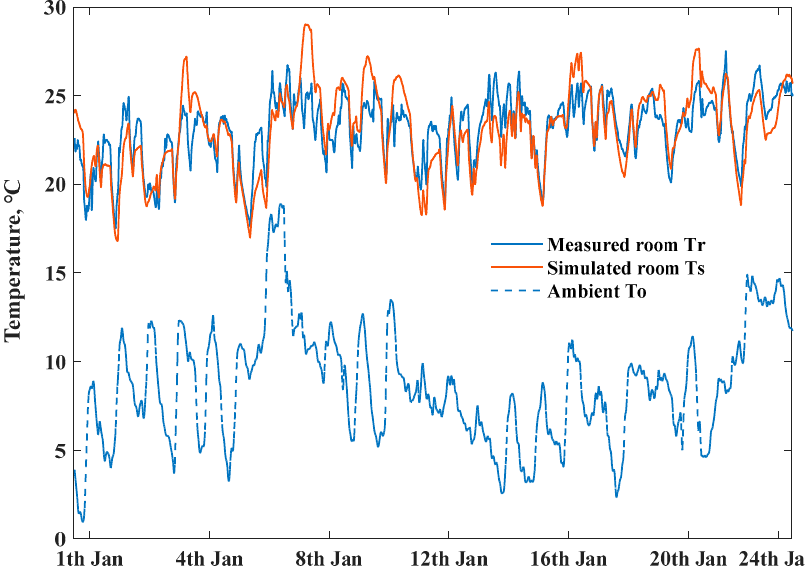
Figure 9. Measured and simulated room air temperature profiles of ZEHs with heat loss coefficient, Q is 1.91 W/ ( m 2 · K ) .